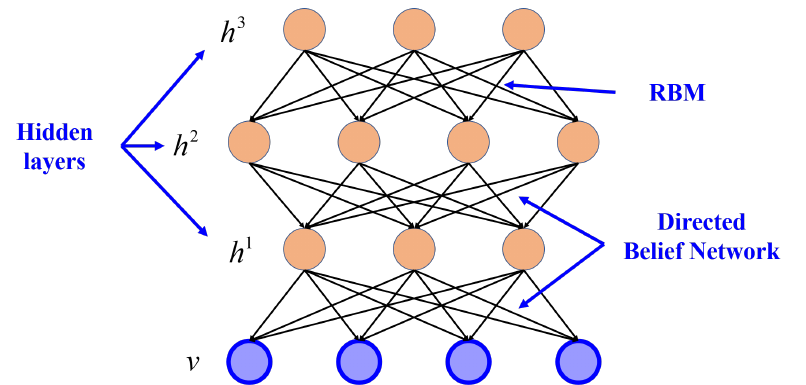
Figure 7. Example of Deep belief network